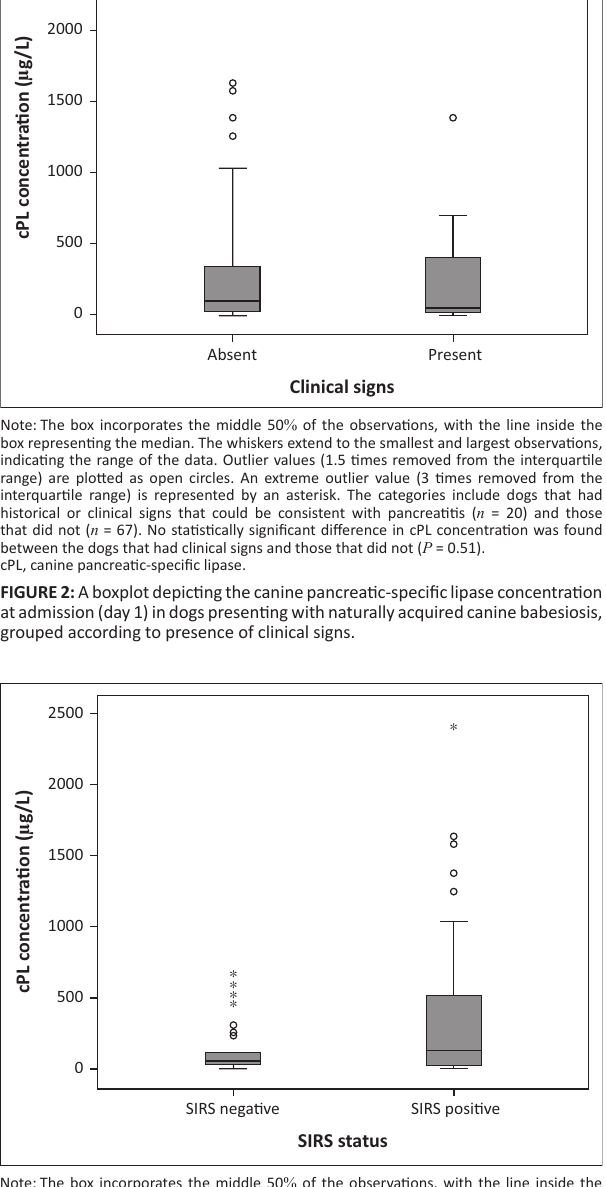
TABLE 1: The results of the Spearman’s rank order correlation ( r pancreatic-specific lipase concentration and various clinical, haematological, biochemical and endocrine parameters in dogs with naturally acquired canine babesiosis caused by Babesia rossi infection ( P ≤